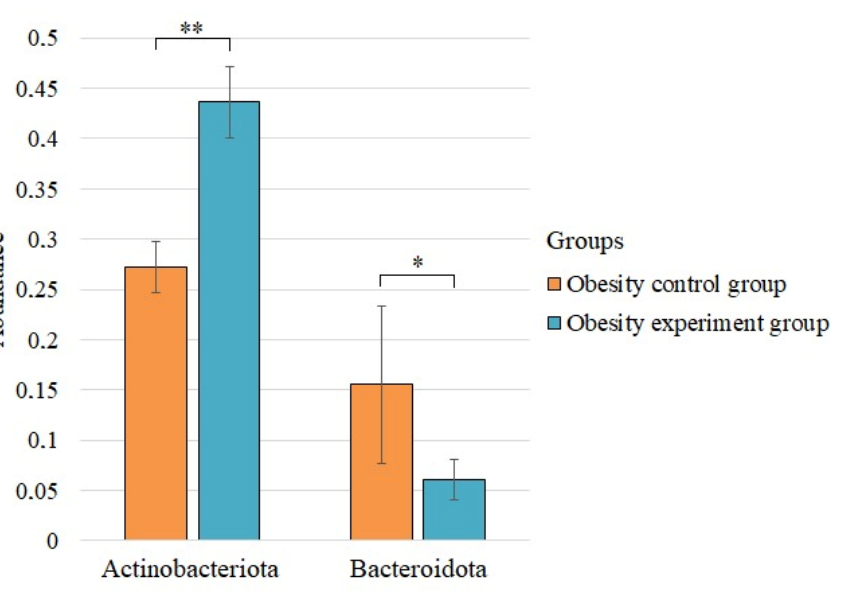
Figure 2. The statistically significant differences in the phylum composition of the control group of obesity and the group of patients with obesity after taking lactic acid bacteria. * p < 0.05; ** p < 0.01. The abundance of the phylum Actinobacteriota increased significantly after supple- mentation with lactic acid bacteria, while the abundance of Bacteroidota